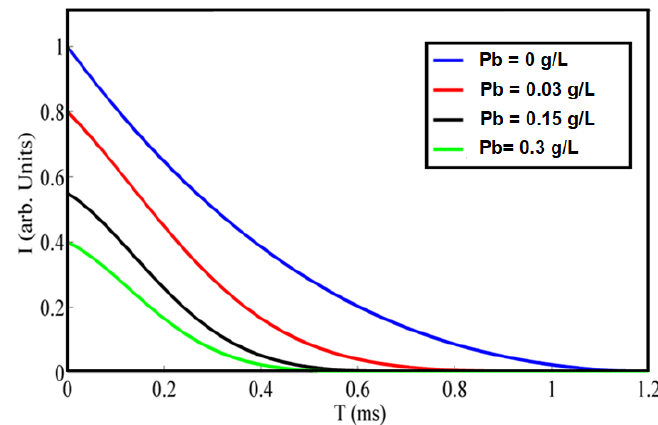
Figure 9. Fluorescene lifetime change of gold-ceria nanoparticles due to different concentrations of lead quencher.